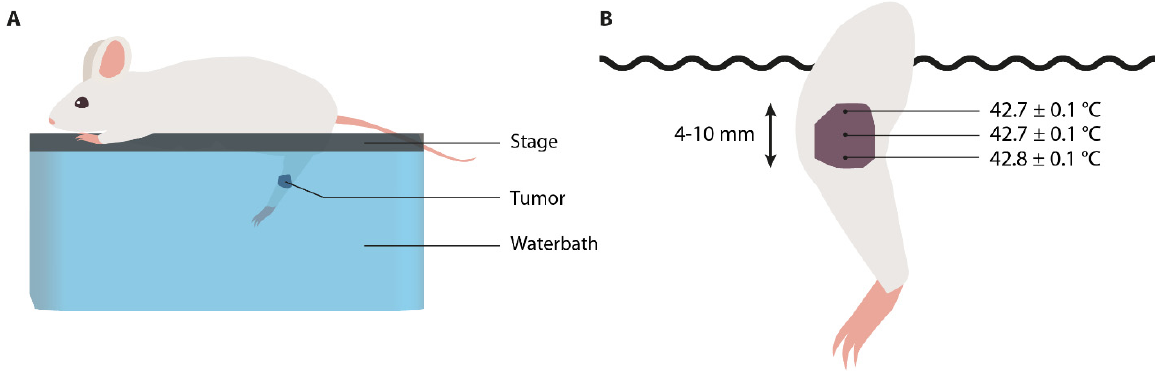
Figure 2. Illustrations of a water bath unit for hyperthermia application. ( A ) Immersion of the target region in a temperature-controlled water bath; ( B ) the intratumoral temperature distribution of a tumor-bearing leg immersed (43 °C, 5 min). The aligned temperature probes were placed in the tumor center at different depths in relation to the water surface. Image B is adapted from Nishimura et al. [29].